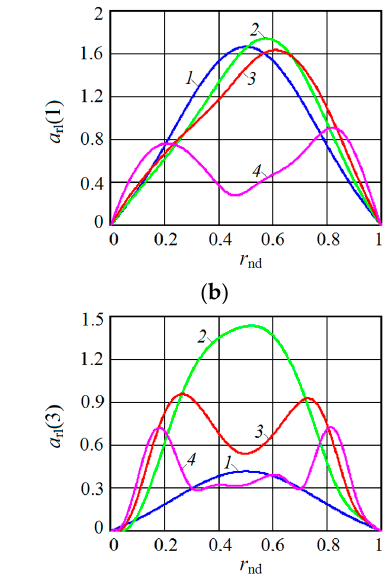
Figure 5. Plots of CAS section along the axis and ( d ) third a rl ( 3 ) harmonics of the modulation frequency calculated at m AM = 0.8 for di ff erent values of k FM . On plot a : k FM = 0 (curve 1), k FM = 0.4 (curve 2), k FM = 0.8 (curve 3), k FM = 1.2 (curve 4). On plot b : k FM = 0 (curve 1), k FM = 0.5 (curve 2), k FM = 1 (curve 3), k FM = 2 (curve 4). On plot c : k FM = 0 (curve 1), k FM = 1 (curve 2), k FM = 2 (curve 3), k FM = 3 (curve 4). On plot d : k FM = 0 (curve